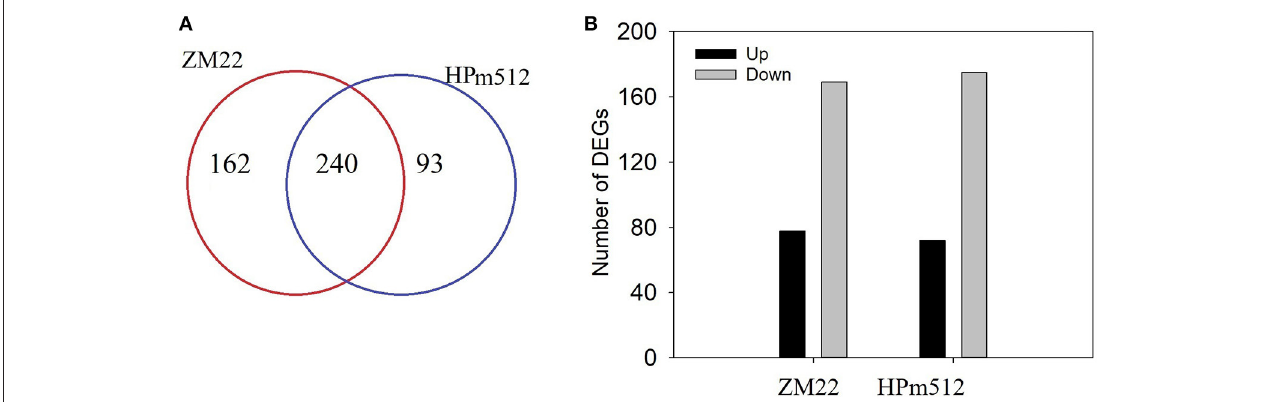
FIGURE 6 | The number of DEGs in wheat grains at 20 DAA and 30 DAA. (A) The number of total DEGs involved in phenolic biosynthesis, glycosyltransferase, and transcription factor activity. (B) The number of DEGs shared by ZM22 and HPm512 (20 DAA vs. 30 DAA).